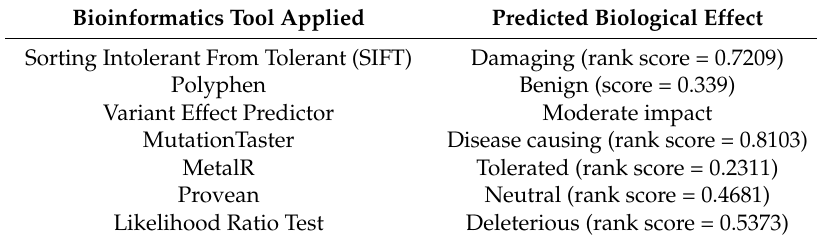
Table 1. Bioinformatics analysis of missense mutation RAD50 R385C as a variant of uncertain clinical